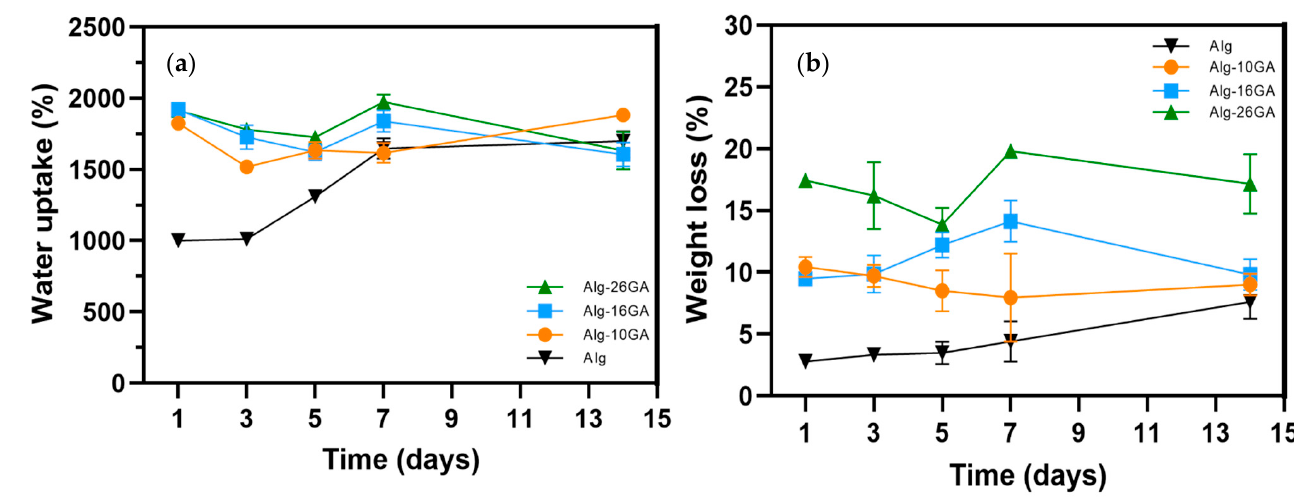
Figure 8. Water uptake ( a ) and degradation behavior ( b ) of Alg-xGA (x=0, 10, 16, and 26 wt.%) composites.